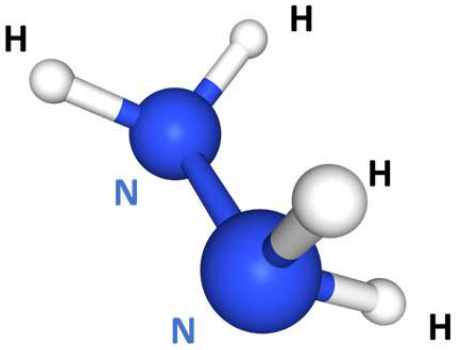
Figure 1. Ball stick model of hydrazine (N 2 H 4 ) with N atoms and H atoms.